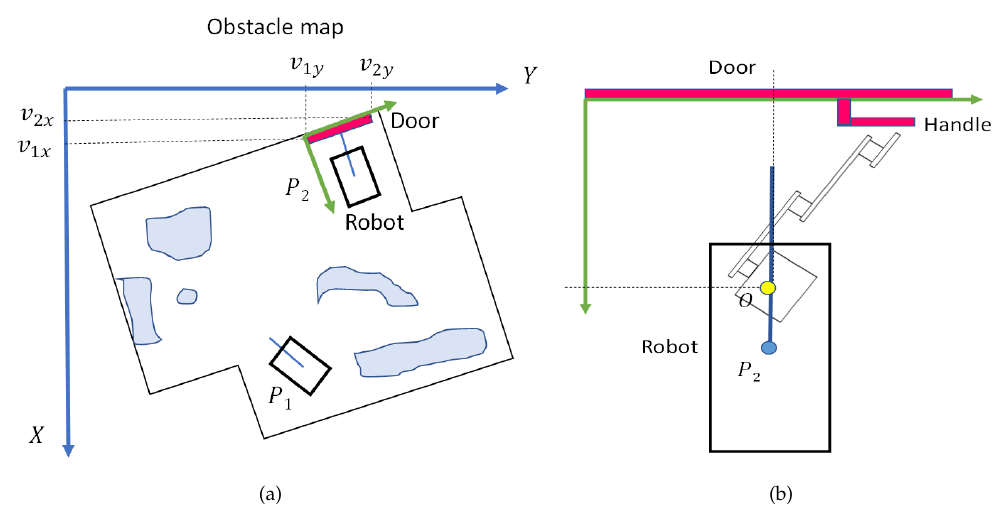
Figure 5. ( a ) Representation on the world coordinate system. Obstacle map and initial and final positions of the robot. ( b ) Position and orientation of the robot in front of the door.